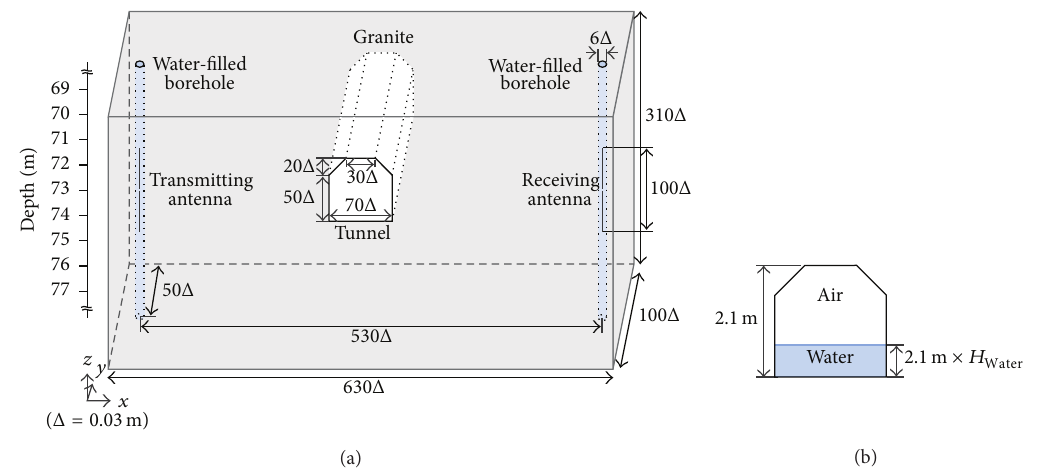
Figure 2: Numerical model of a cross-borehole pulse radar in a well-suited tunnel test site in Korea. (a) Three-dimensional numerical model. (b) Height of collected water inside the tunnel expressed using the height ratio of water 𝐻